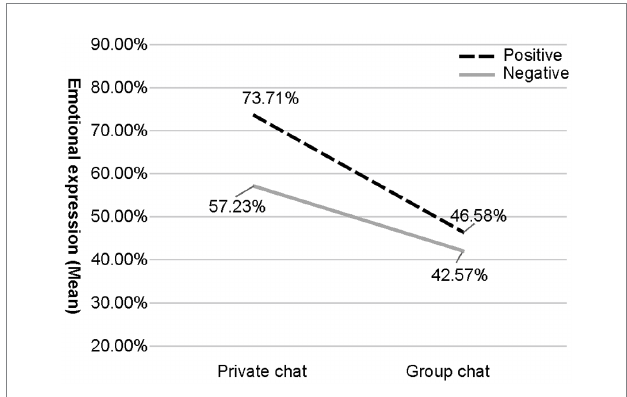
FIGURE 3 Emotional expression (mean) in different social contexts. The mean was based on the midpoint of each quintile (e.g., 10% for